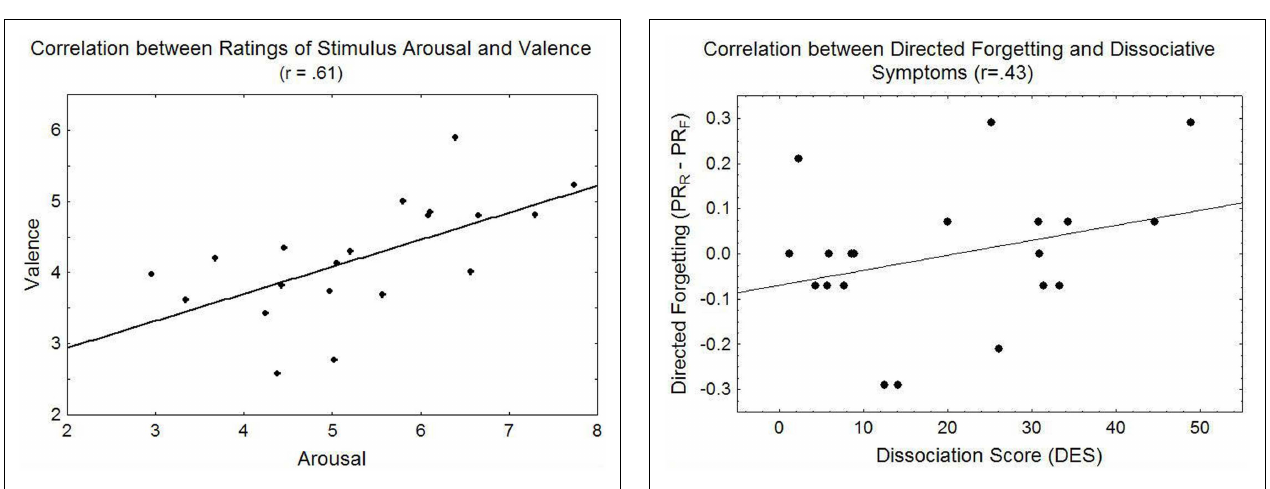
FIGURE 3 | Relationship between valence and arousal ratings in the present sample .